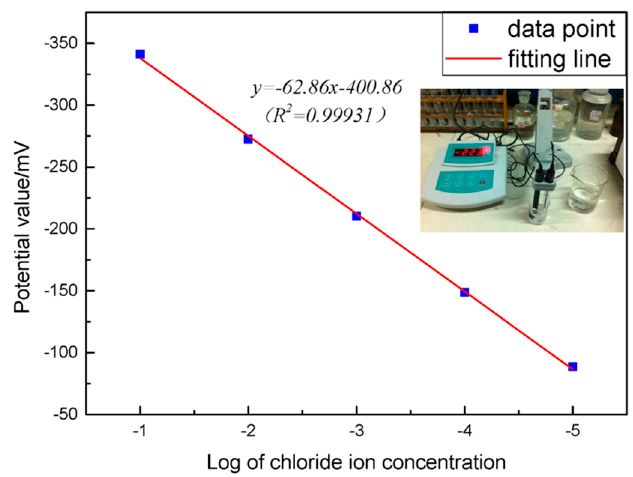
Figure 1. Potential value and chloride ion concentration logarithm.